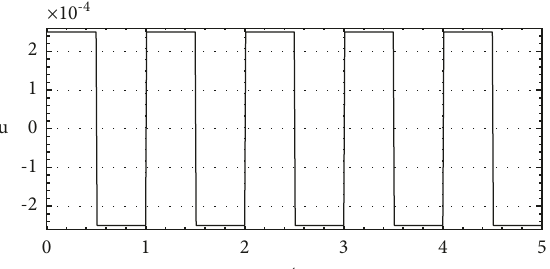
Figure 12: Time series of the square load torque when T � 0.00025, F � 1Hz, when the load torque has a square form, we obtained the 3 bifurcation diagram and the local maximum exponent by varying the amplitude of the signal as given in Figure 13.